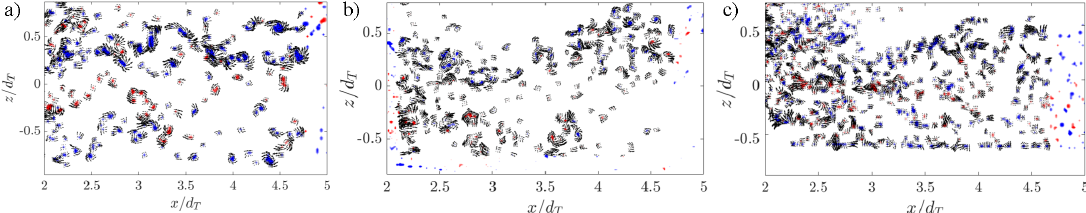
Figure 9. Instantaneous swirling strength distributions Λ ci d T / U hub in the center plane ( y = 0) for